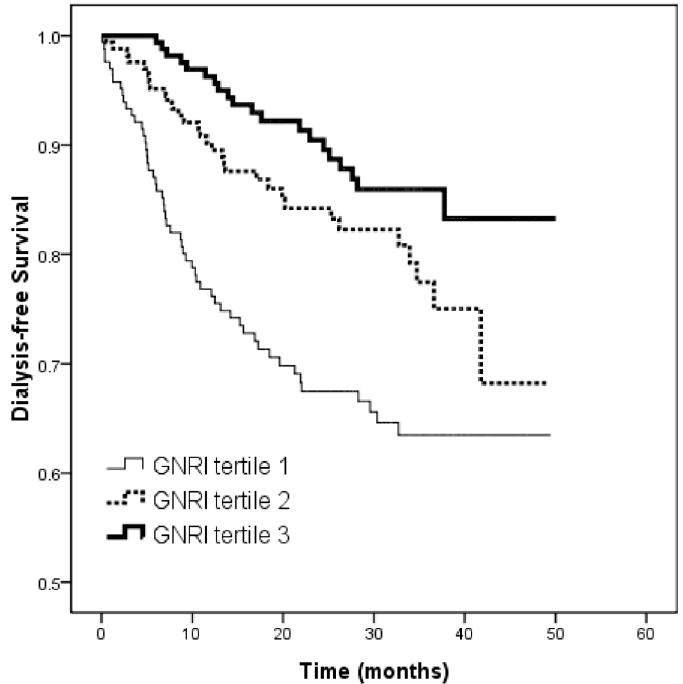
Figure 1. Kaplan-Meier analysis of dialysis-free survival according to tertiles of GNRI in patients with chronic kidney disease (log-rank p < 0.001). The group with the highest two tertiles had a better dialysis-free survival (all p < 0.05) than that with the lowest tertile of GNRI.